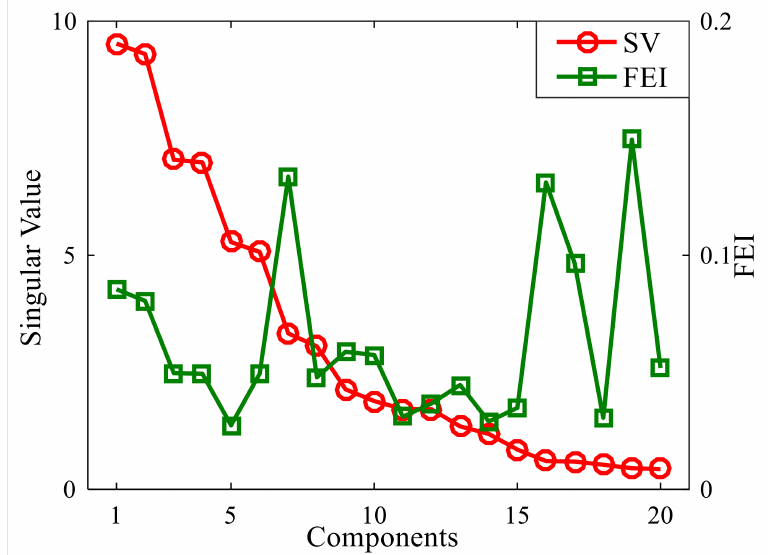
Figure 15. Comparison between singular value and